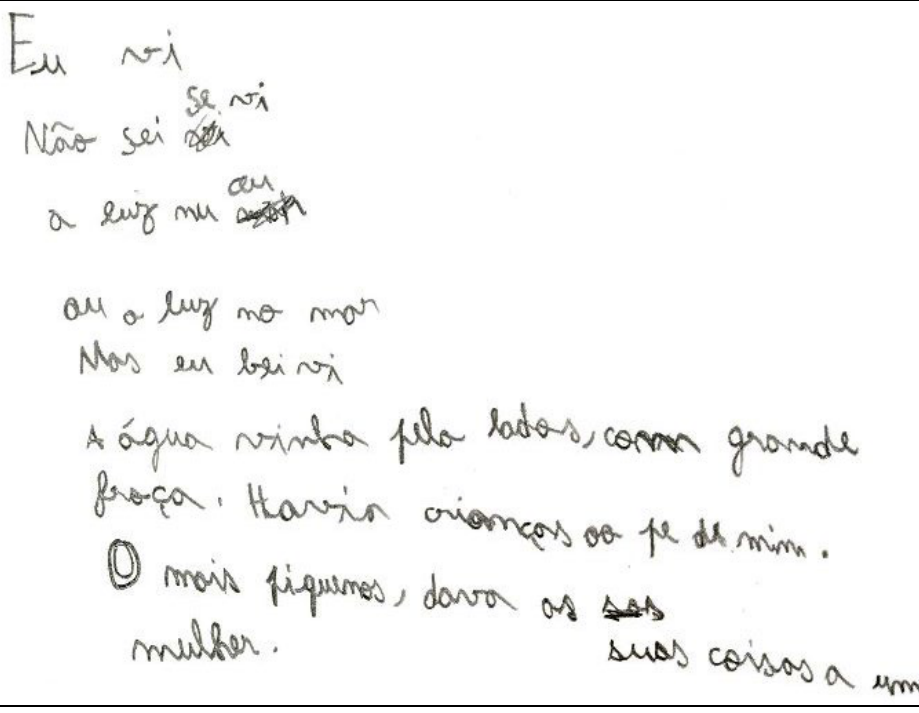
Figure 3. Handwriting example of the BHK text (Portuguese version is shown in Figure 2 and the English translation is shown in Appendix A) copied for 5 min by a participant on a blank A4 sheet of paper in landscape orientation. (Image was reduced and cropped. The border measured in reality 18.4 cm × 13.5 cm.)